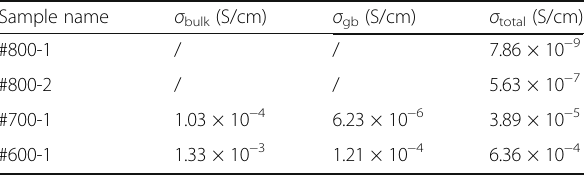
Table 2 Bulk ionic conductivities ( σ bulk ), grain boundary ionic conductivities ( σ gb ), and total ionic conductivities ( σ total ) at room temperature of the presented LLZO thin